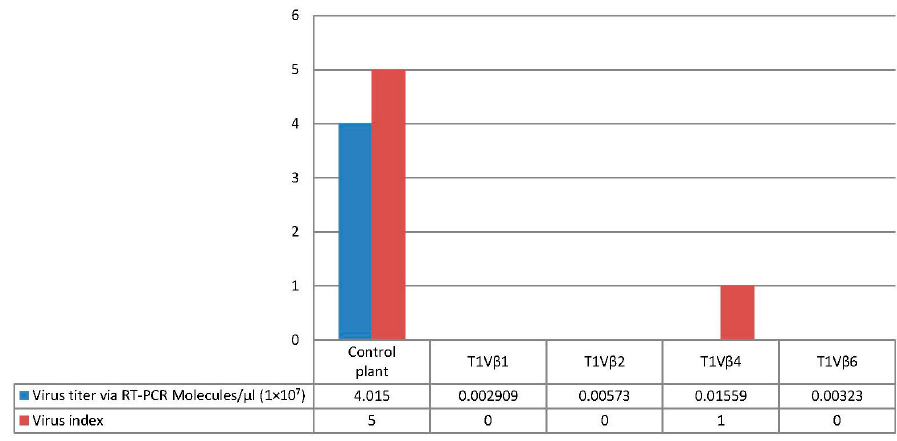
Figure 6. Comparison of disease severity score and virus accumulation in the T 1 transgenic cotton plants, lines T1V β 1, T1V β 2, T1V β 4, T1V β 6, and a non-transgenic, control cotton plant.